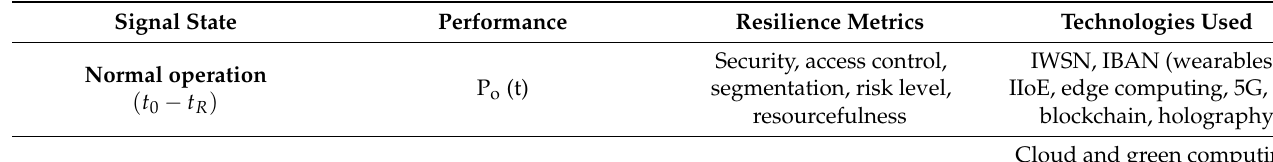
Table 8. Performance